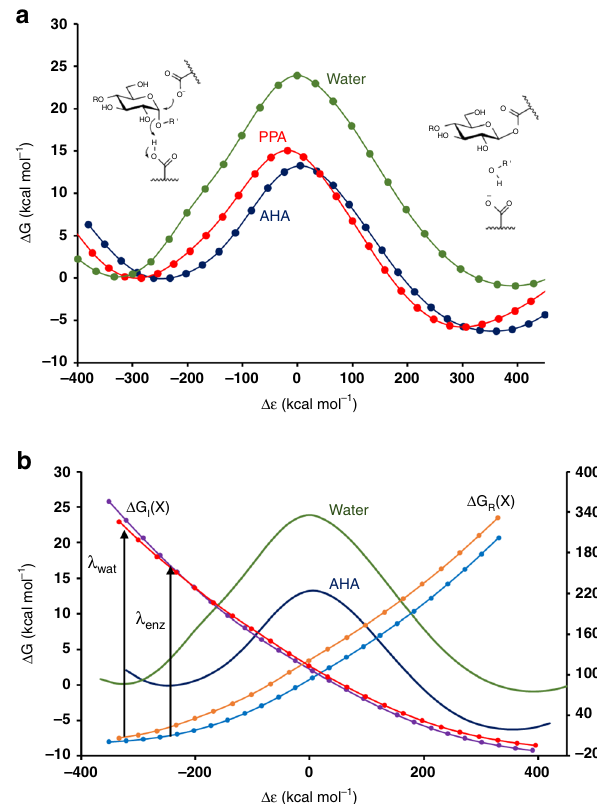
Fig. 2 Reaction free energy pro fi les. a Calculated free energy pro fi les from reactants to the covalent intermediate for the reference reaction in solution (green) and two α -amylases: psychrophilic AHA (blue) and mesophilic PPA (green). Δ ε is the generalized reaction coordinate 33,34 , and the s.e.m. for the free energy barriers is 0.08 – 0.14 kcal mol − 1 (from ~300 replicate simulations). b Illustration of the reorganization energy effect in AHA. The reaction free energy pro fi les for the reference reaction (green) and AHA (blue) are shown (left-hand y axis) together with the diabatic free energy functions corresponding to the pure reactant ( Δ G R — orange and light blue for water and enzyme, respectively) and intermediate ( Δ G I — red and purple for water and enzyme, respectively) states in the two cases (right- hand y axis). The reorganization energies are indicated with vertical